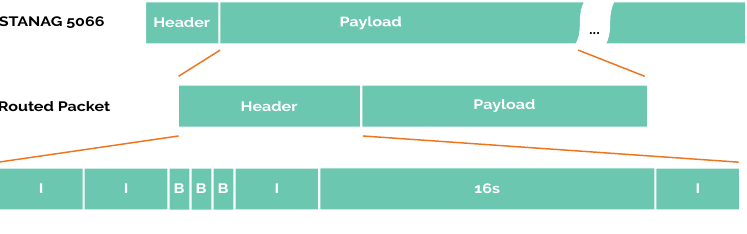
Figure 8. Packet